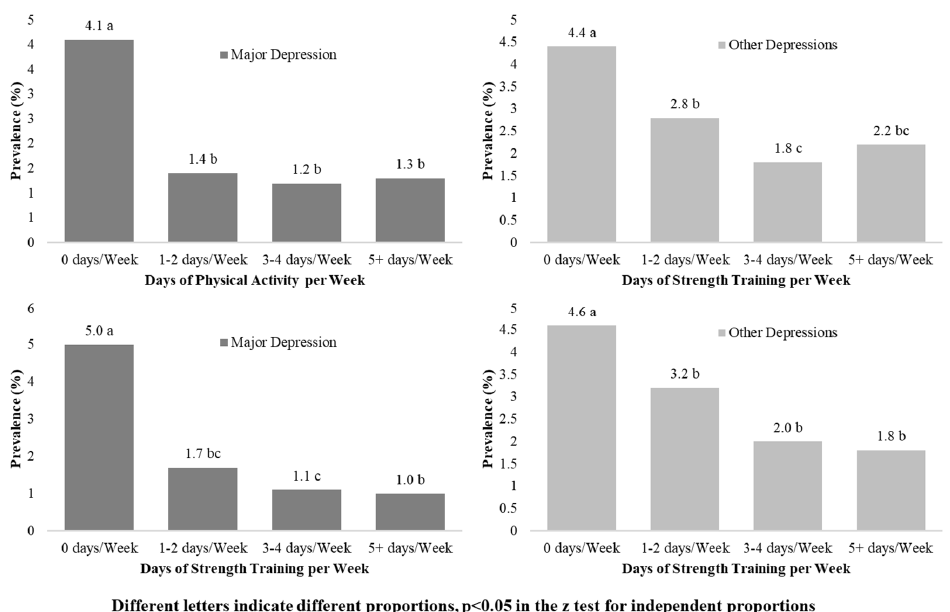
Figure 4. Prevalence of major depression and other types of depression, according to the PA and strength training days performed a